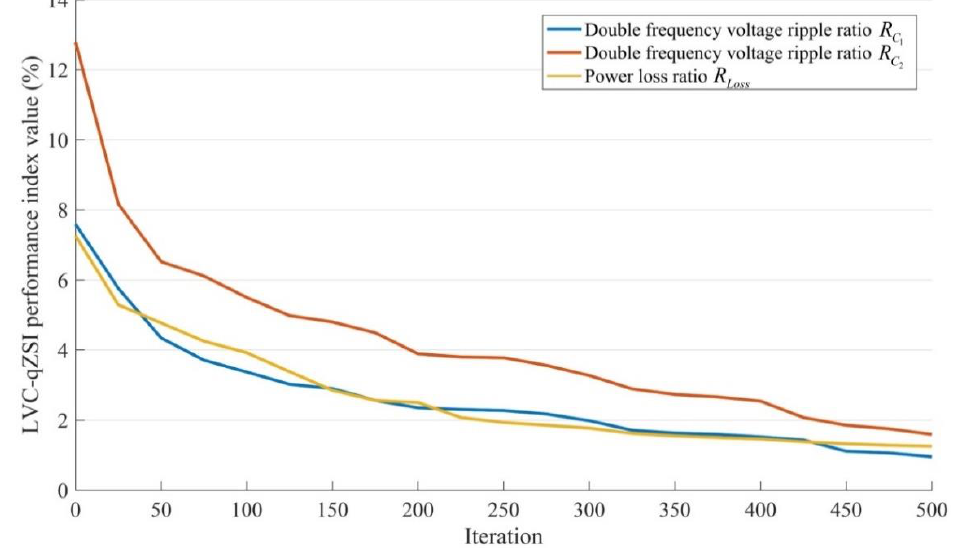
Figure 11. Curves of double frequency voltage ripples ratios and power loss ratio.